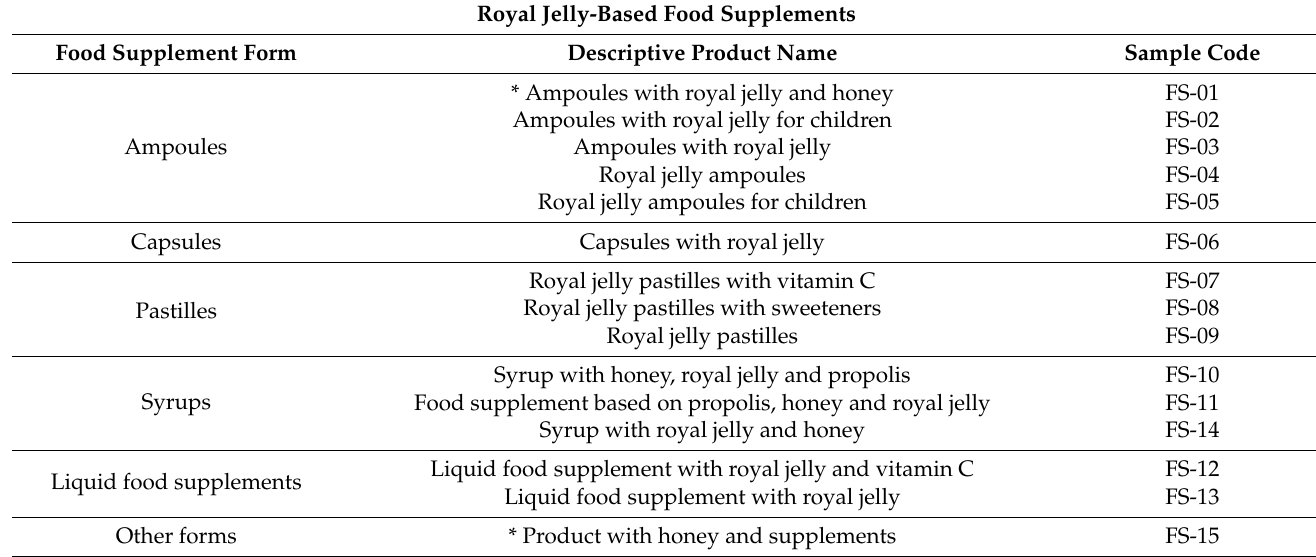
Table 1. Food supplements used in the